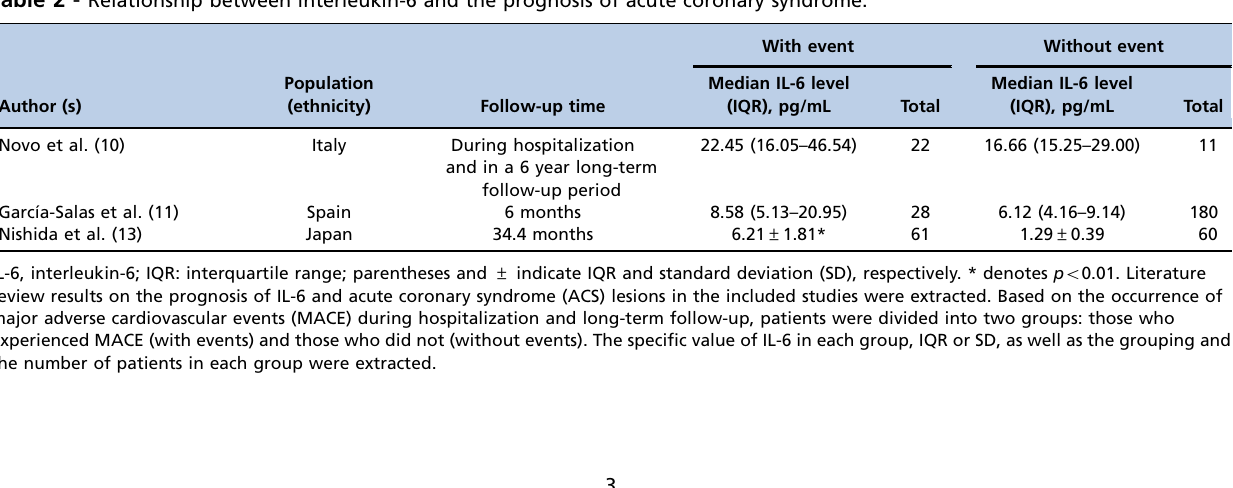
Table 2 - Relationship between interleukin-6 and the prognosis of acute coronary